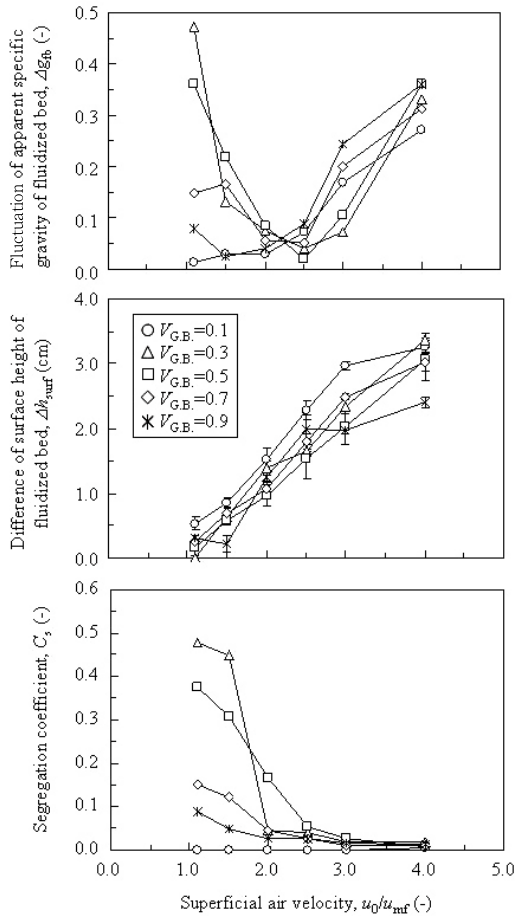
Fig.2 Dependences of apparent specific gravity and average surface